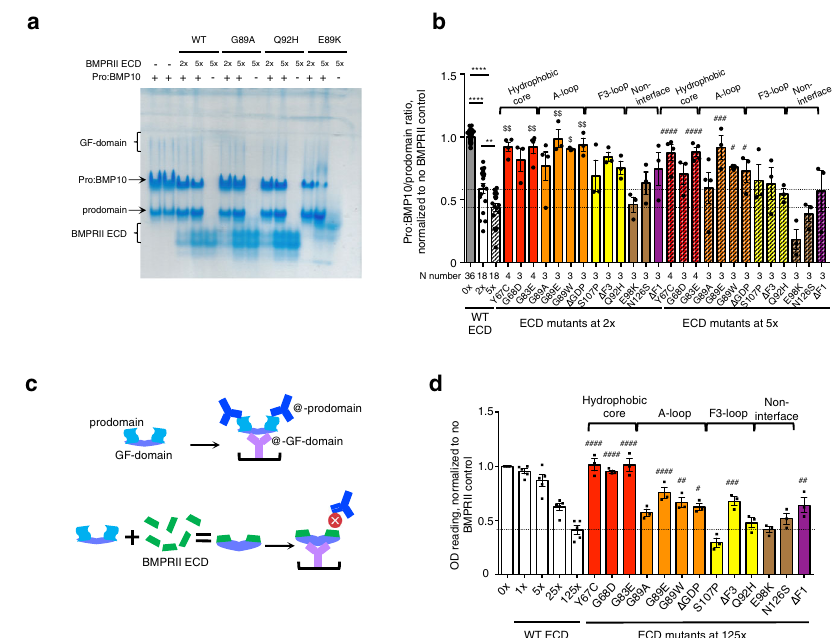
Fig. 8 BMP10:BMPRII interaction is important for prodomain displacement. a A representative native PAGE of prodomain displacement experiment. b Quanti fi cation of native PAGE results. The band intensities of Pro:BMP10 and prodomain were obtained by densitometry using ImageJ. The ratio of Pro:BMP10/prodomain for each lane was calculated, then normalised to that of the WT control run on the same gel. Each mutant protein was run on at least three independent native PAGE experiments, with two WT controls on each gel to allow normalisation. Final N numbers for each sample are labelled below the graph. Conditions with BMPRII ECDs at 2-fold excess (2x) are shown in open bars, and those with 5x in hashed bars. The two dotted lines mark the mean values for 2x and 5x WT BMPRII, respectively. Data are presented as mean values + / − SEM. One-way ANOVA analysis for WT ECD group, **** P < 0.0001, ** P < 0.01; for BMPRII at 2x excess group, Dunnett ’ s post test comparing with WT BMPRII ECD, $ P < 0.05, $$ P < 0.01; for BMPRII at 5x excess group, Dunnett ’ s post test comparing with WT BMPRII ECD, # P < 0.05, ### P < 0.001, #### P < 0.0001. c Schematic depicting the experiment of the prodomain displacement by ELISA. d Quantitative results of prodomain displacement by ELISA. All readings are normalised to the WT on the same plate. N = 5 for WT ECD, N = 3 for each mutant protein. Each N number represents an independent ELISA experiment. Data are presented as mean values + / − SEM. One-way ANOVA analysis for BMPRII at 125x excess, with Dunnett ’ s post test comparing with WT BMPRII ECD (mean value shown as a dotted line). # P < 0.05, ## P < 0.01, ### P < 0.001, #### P < 0.0001. In b , d , coloured in red are residues near the hydrophobic triad, in orange are residues from the A- loop, in yellow are F3-loop; in brown, non-interface residues, and in purple, F1-loop which is not visible in the structure. Source data, including the exact p values for b , d , are provided as a Source Data fi le. ECD = extracellular domain, GF-domain = growth factor domain, Pro:BMP10 = non-covalent complex of BMP10 prodomain with its